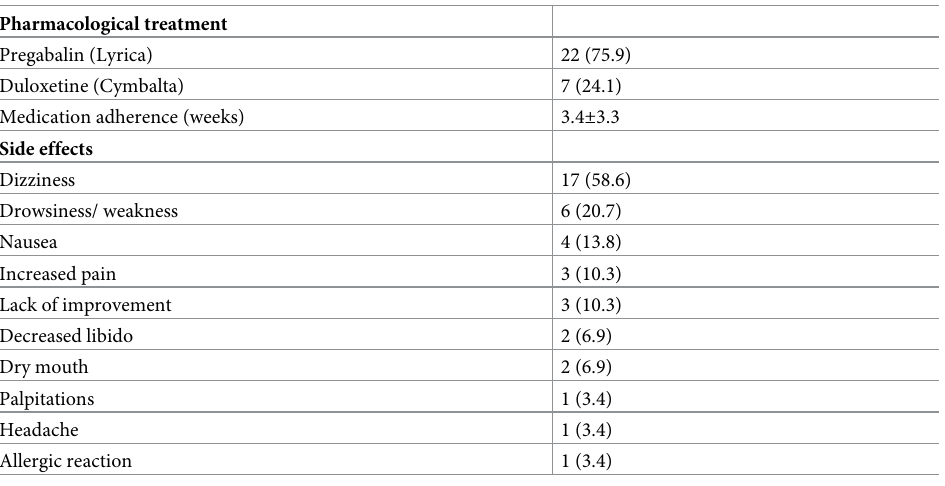
Table 4. Pharmacological treatment and side